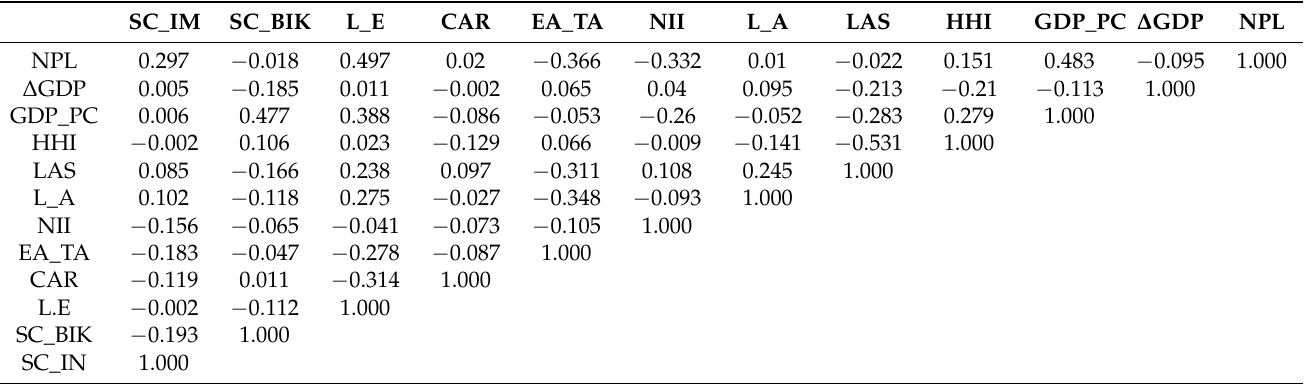
Table 4. Correlation matrix of variables used in the